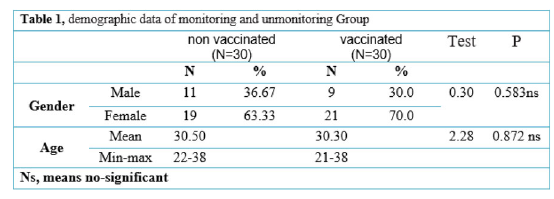
Table 1 (abstract P77). Demographic data of monitoring and unmonitoring